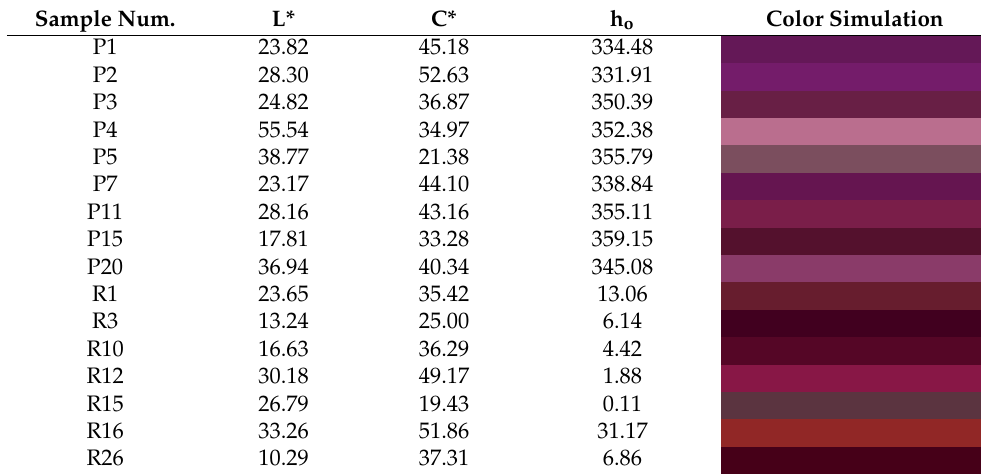
Table 4. Color quantization of investigated pyrope-almandine, and the color simulation which is transformed by COLORTELL website. (http://www.colortell.com, accessed on 6 October 2021). Sample